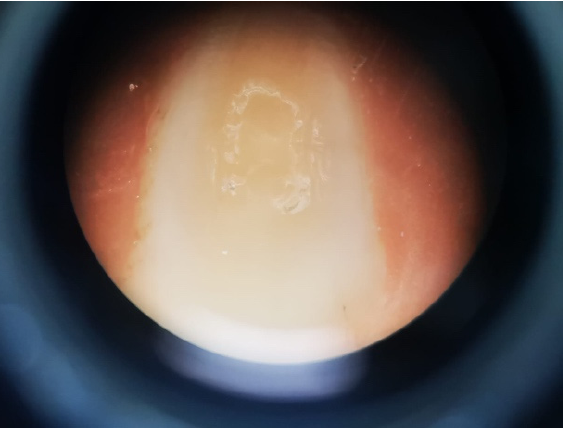
Figure 4. Representative image of the adhesive failure mode of the specimens.